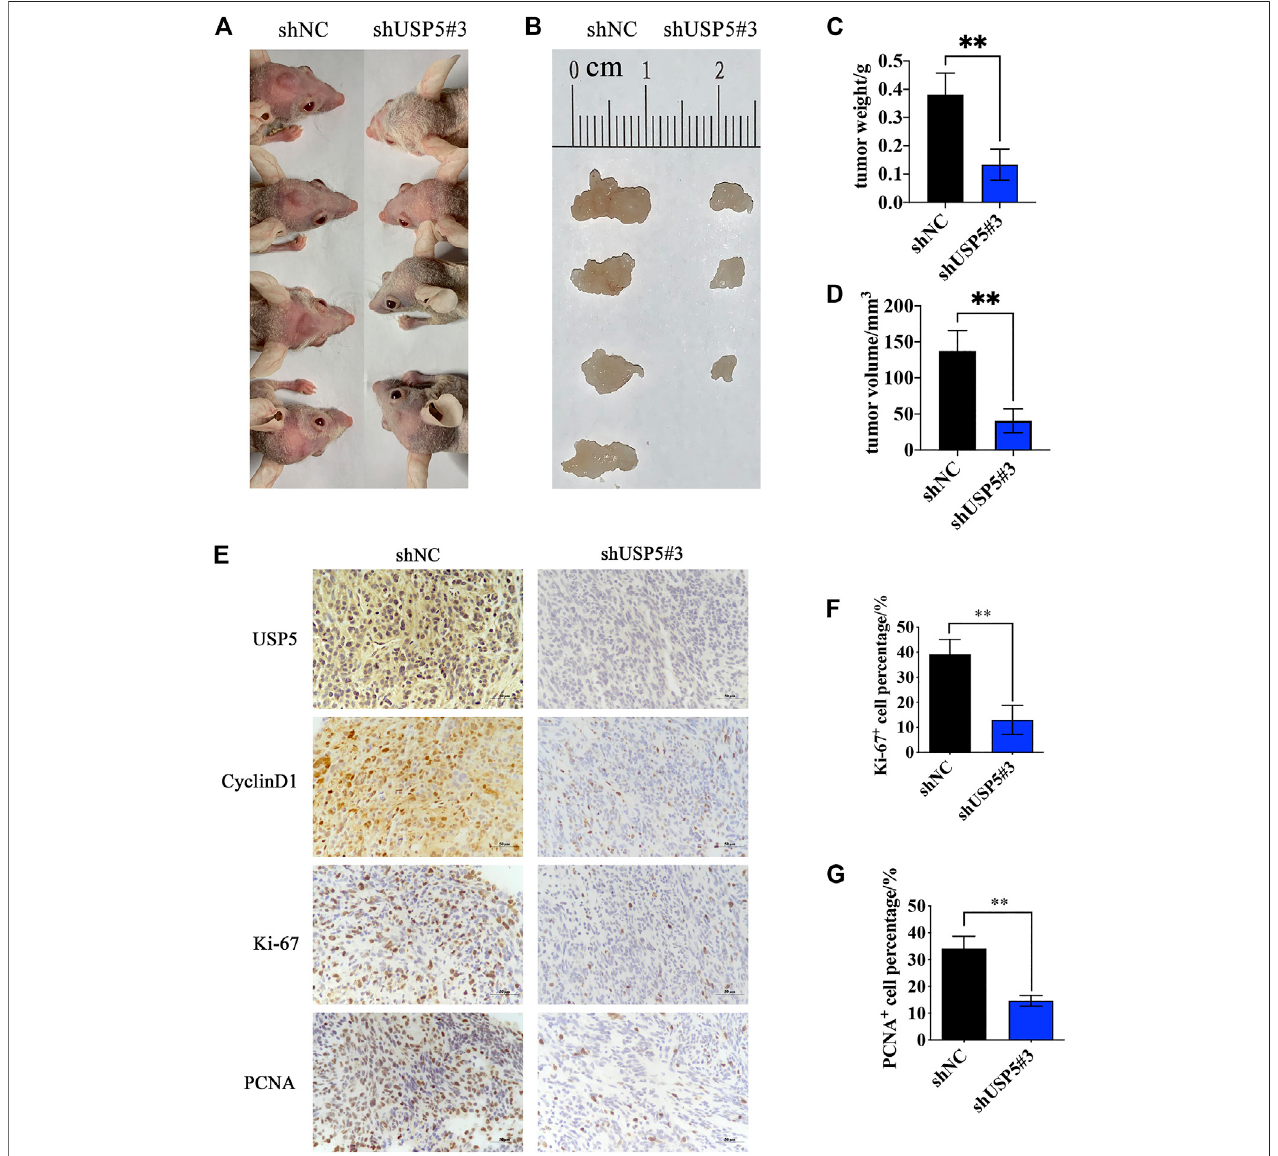
FIGURE 5 | Ablation of USP5 impaired the tumorigenicity of GBM cells in vivo . 5 × 10 5 U251 stably expressed shNC or shUSP5#3 were intracranially injected into nudemice,respectively( n (cid:2) 4).ShRNAexpressionwasinducedby2 mg/mlDOXindrinkingwater,andtumorswerecollected30 daysafterinduction (A,B) Photograph ofxenografttumorsfromshNCorshUSP5#3mice (C) Tumorweight fromshNCorshUSP5#3 mice (D) TumorvolumefromshNCorshUSP5#3mice (F) IHC stainingof USP5,CyclinD1,Ki-67,andPCNAinxenografttumorsfromshNCorshUSP5#3mice (F,G) Ki-67orPCNApositivecellscountinIHCstainingsectionsofxenograft tumors from shNC or shUSP5#3 mice (Data were presented with mean ± SD of three independent experiments, * p < 0.05, ** p < 0.01).